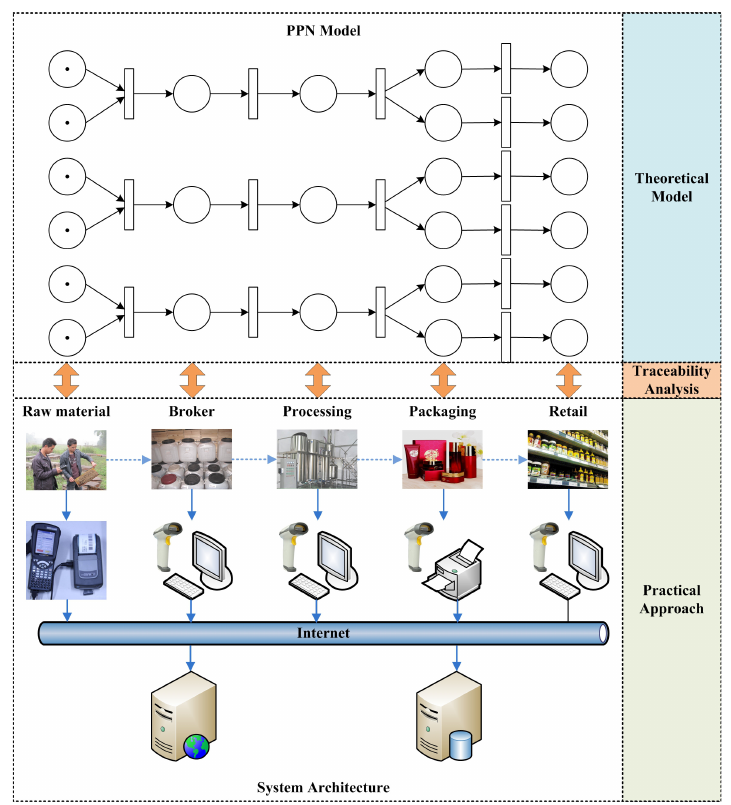
Figure 10. Framework of quality control system for bee products.